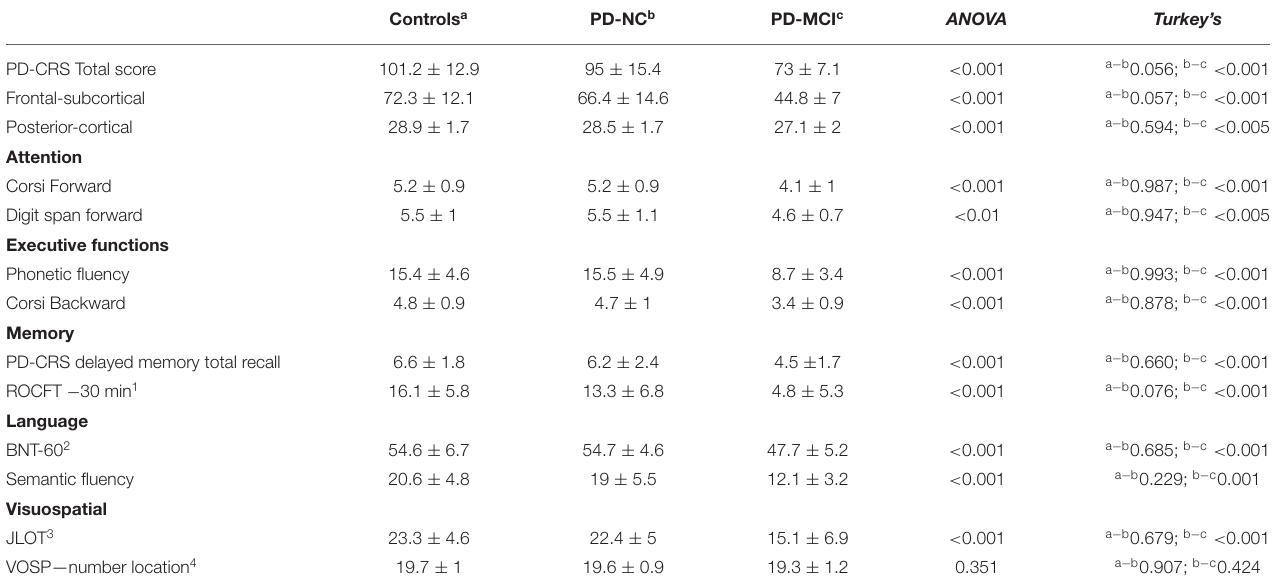
TABLE 2 | Level I and Level II assessment